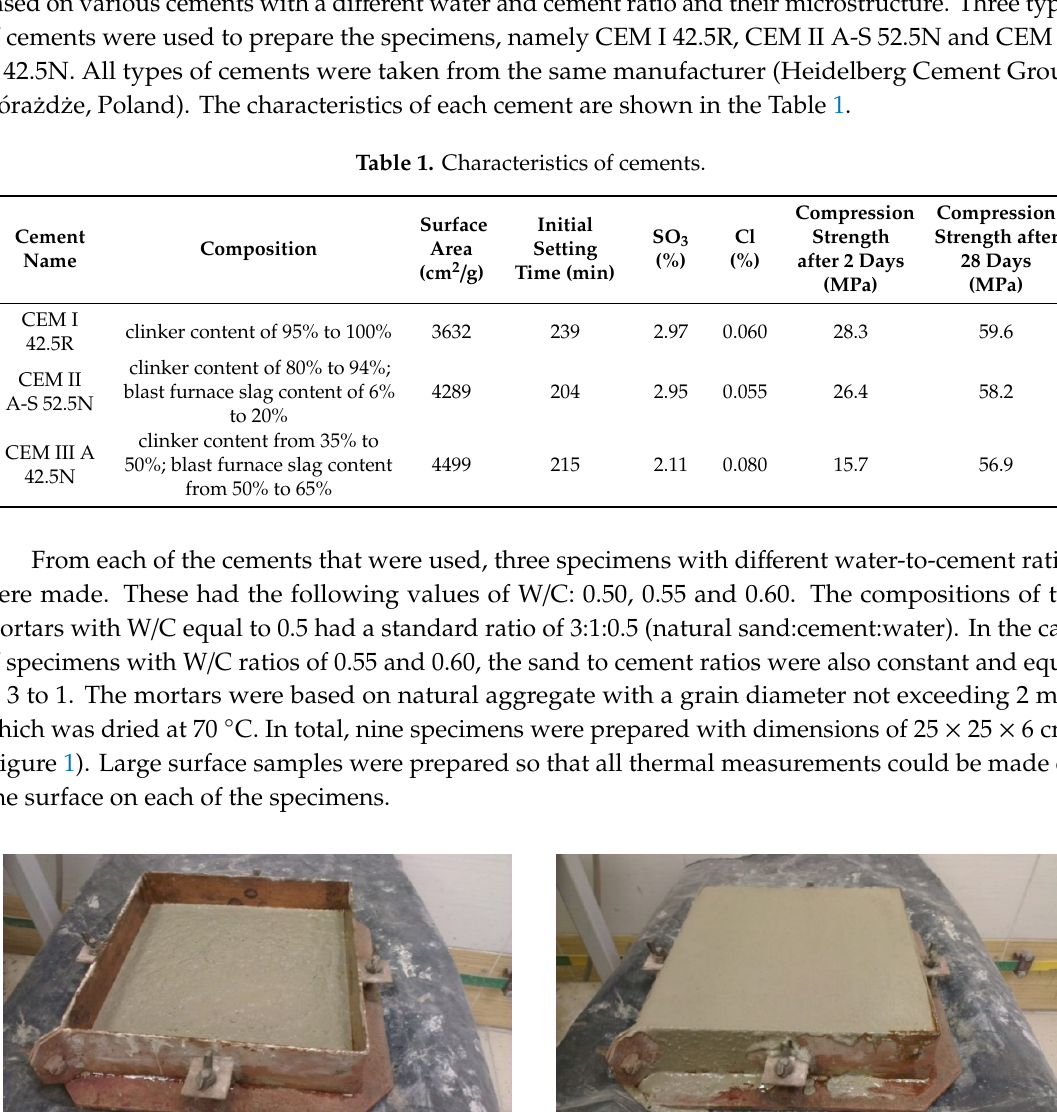
Table 1. Characteristics of cements.